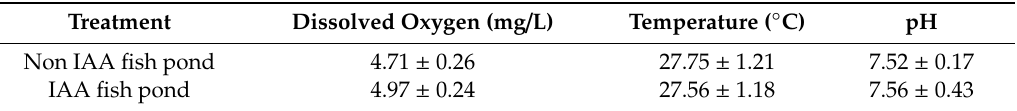
Table 5. Concentration of dissolved oxygen (DO), temperature and pH values in IAA and non-IAA fish ponds during the experimental period (mean ± SE).